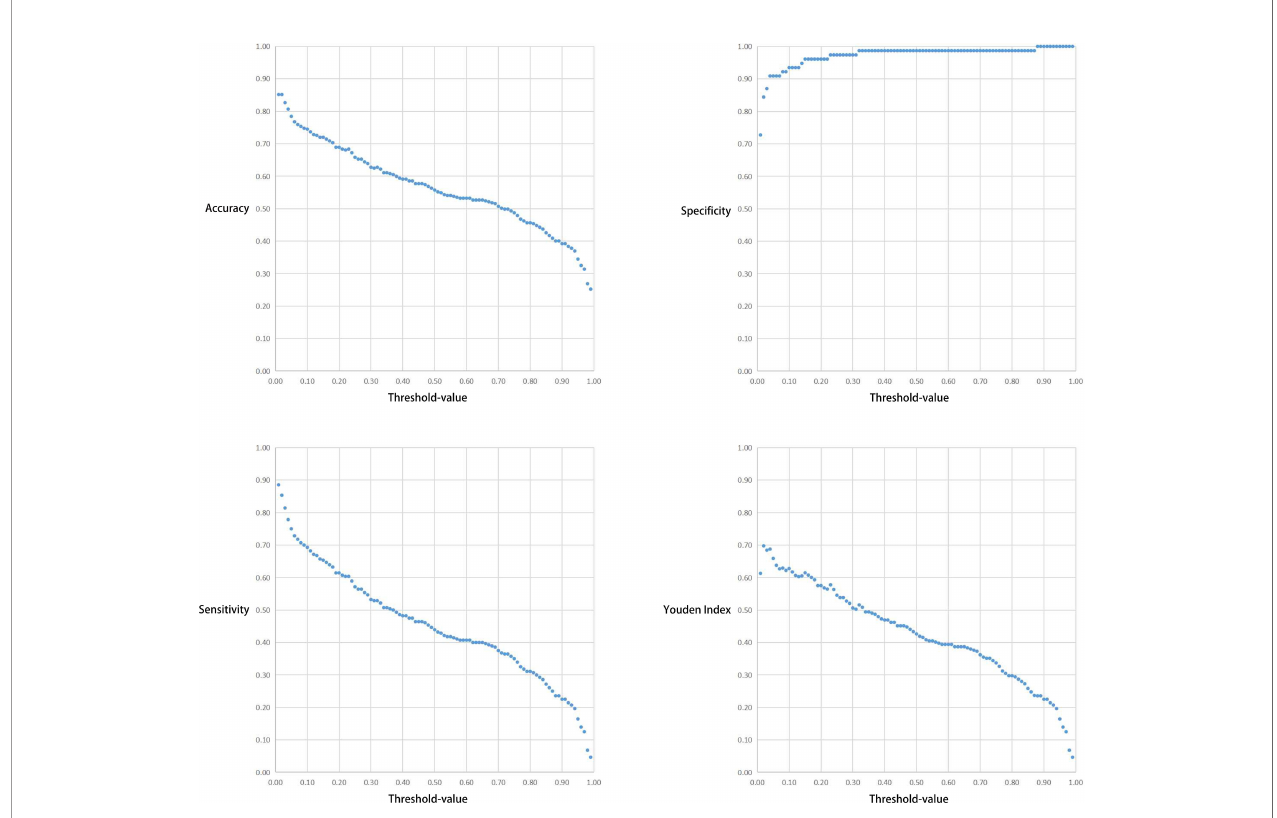
FIGURE 5 | Respective curves of Threshold-values versus Accuracy, Sensitivity, Speci fi city and Youden Index in Test Set